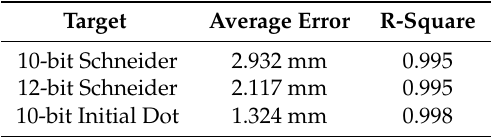
Figure 11. Comparing the result of three experiment. Table 6. Fitting results of the three scattered